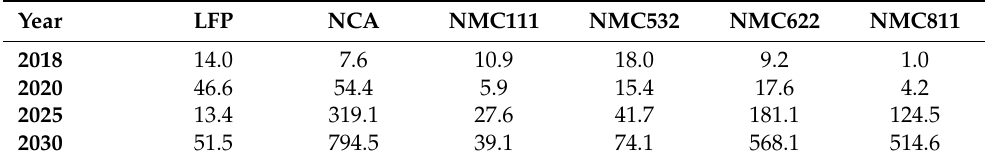
Table A3. Global LIB battery demand by cathode chemistry in GWh for the year 2030, WEF base case [14], including forecasts by Zhao et al. [15] and data from XU et al.